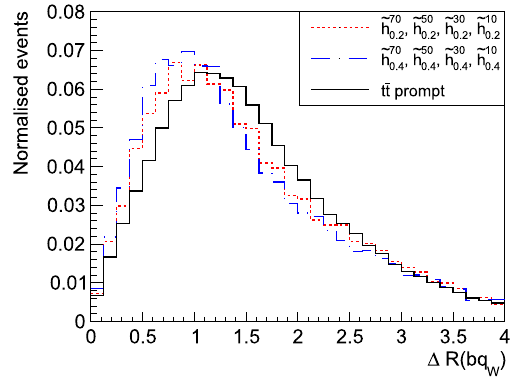
Fig. 40 (cid:6) R distributions in the ˜ h 2 -like case √ F 0 the fundamental scale of supersymmetry breaking. with